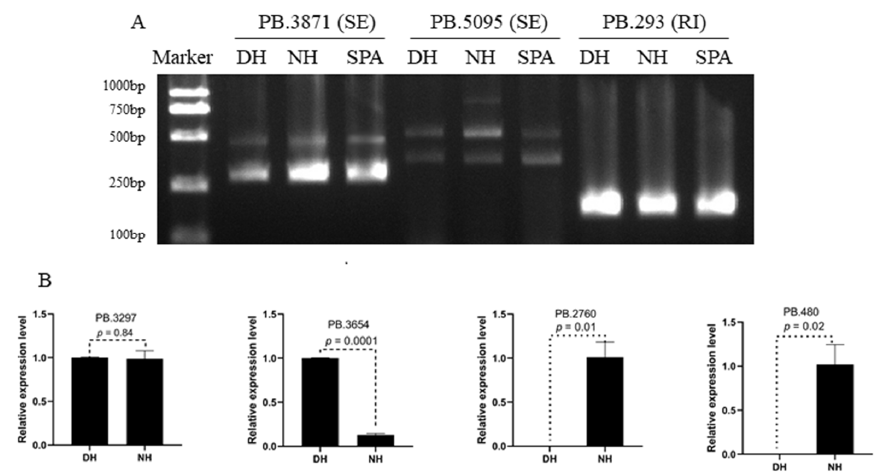
Figure 5. V alidation of alternative splicing (AS) events and significant differential expression genes. ( A ) Validation of AS events by RT ‐ PCR and agarose gel electrophoresis. ( B ) The relative ex ‐ ( A ) Validation of AS events by RT-PCR and agarose gel electrophoresis. ( B ) The relative expression pression level of PB.3297, PB.3654, PB.2760, and PB.480 in NH and DH. level of PB.3297, PB.3654, PB.2760, and PB.480 in NH and